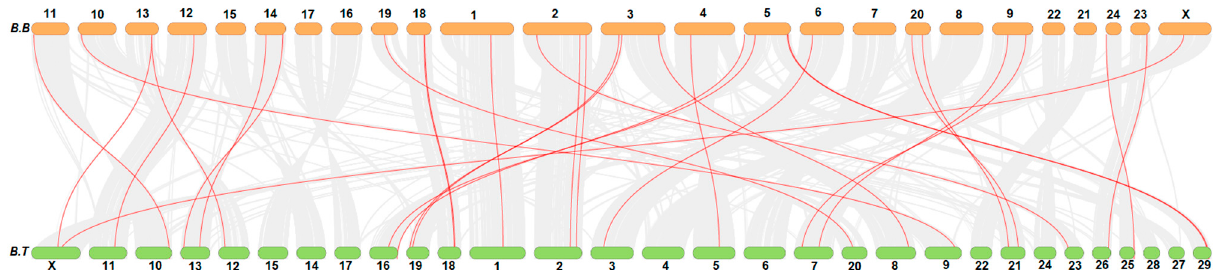
Figure 2. Collinearity analysis of FN-III genes family in buffalo (B.B) and Bos taurus (B.T).